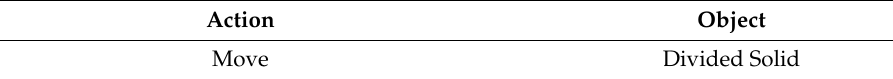
Table 2. Description of parameters.